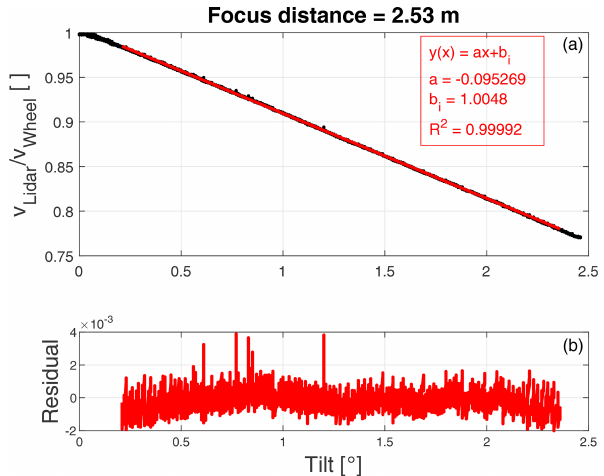
Figure 10. Example of calibration measurement made with a focus setting of 2.53m. The black curve indicates the measurement data and the red curve indicates a least-squares fit of a straight line to the data. Panel (b) shows the residuals of the fit.